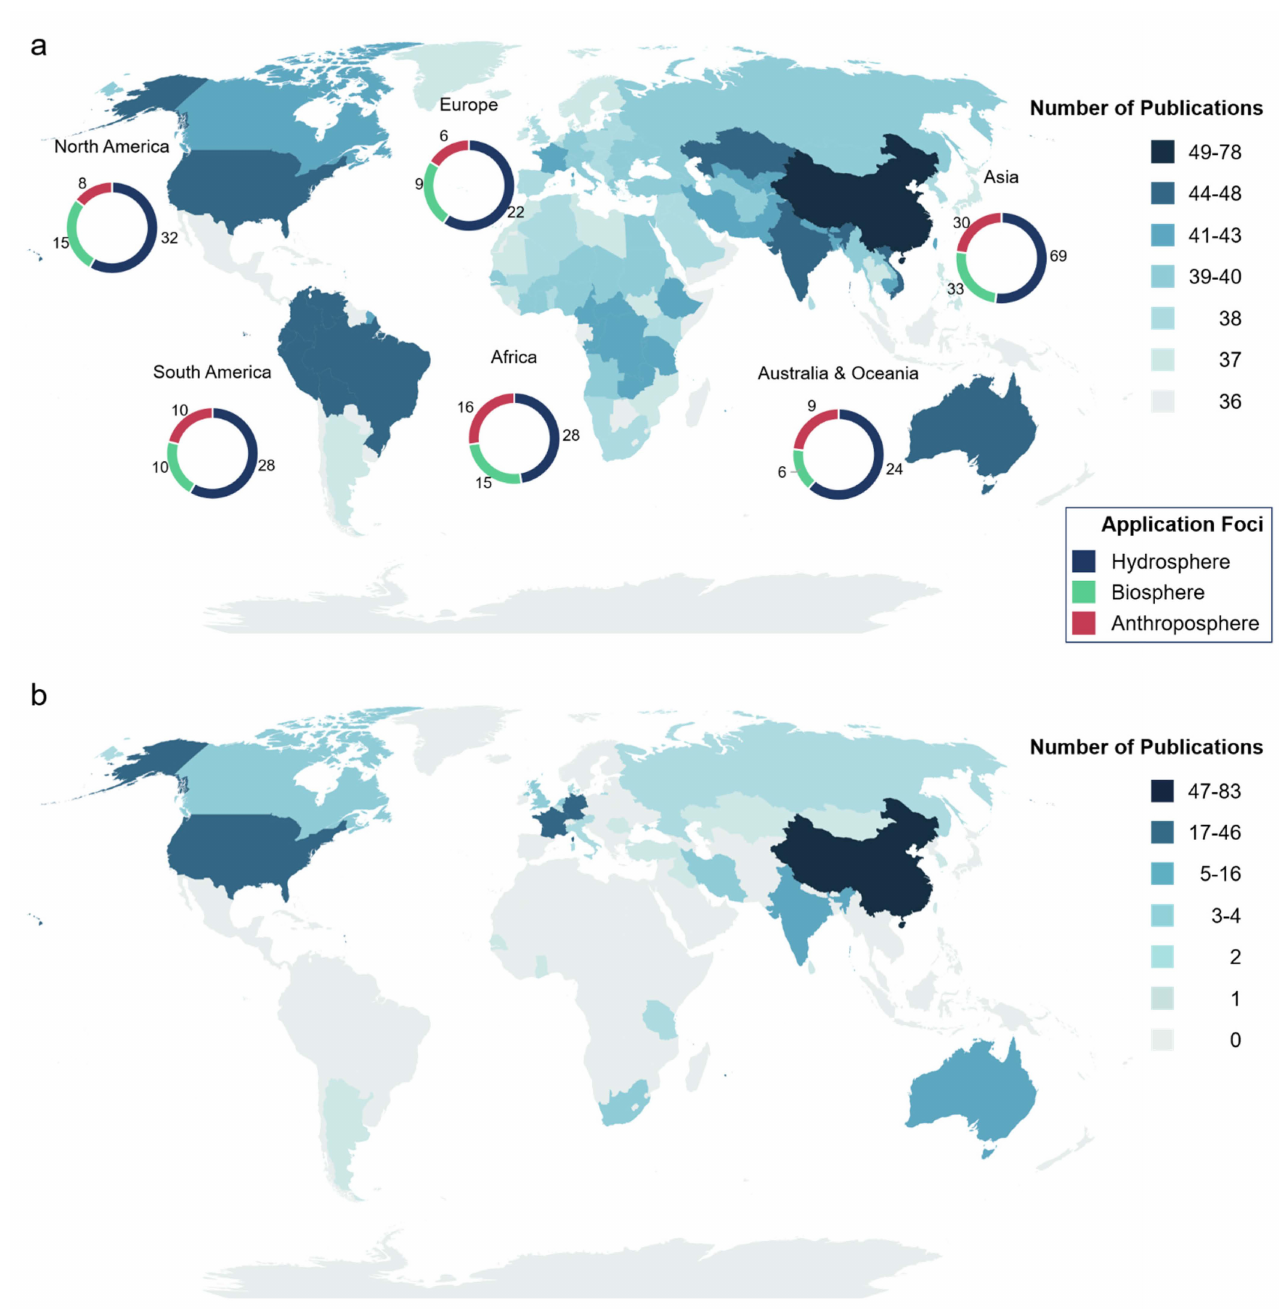
Figure 4. Global spatial distribution of ( a ) investigated areas and application focus distribution with number of publications per continent and ( b ) first